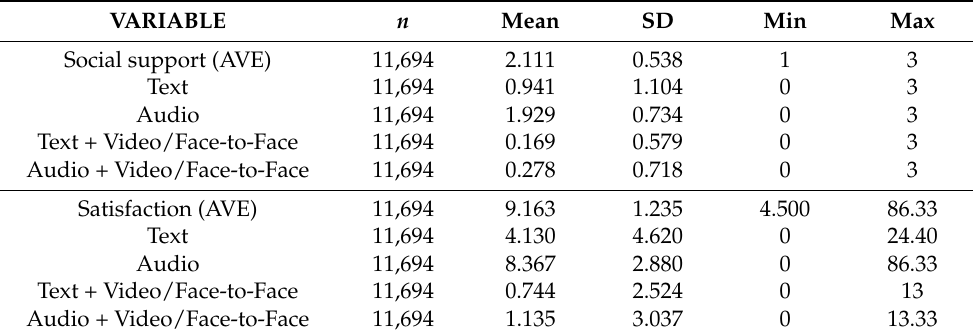
Table 11. Descriptive statistics—perceived social support and